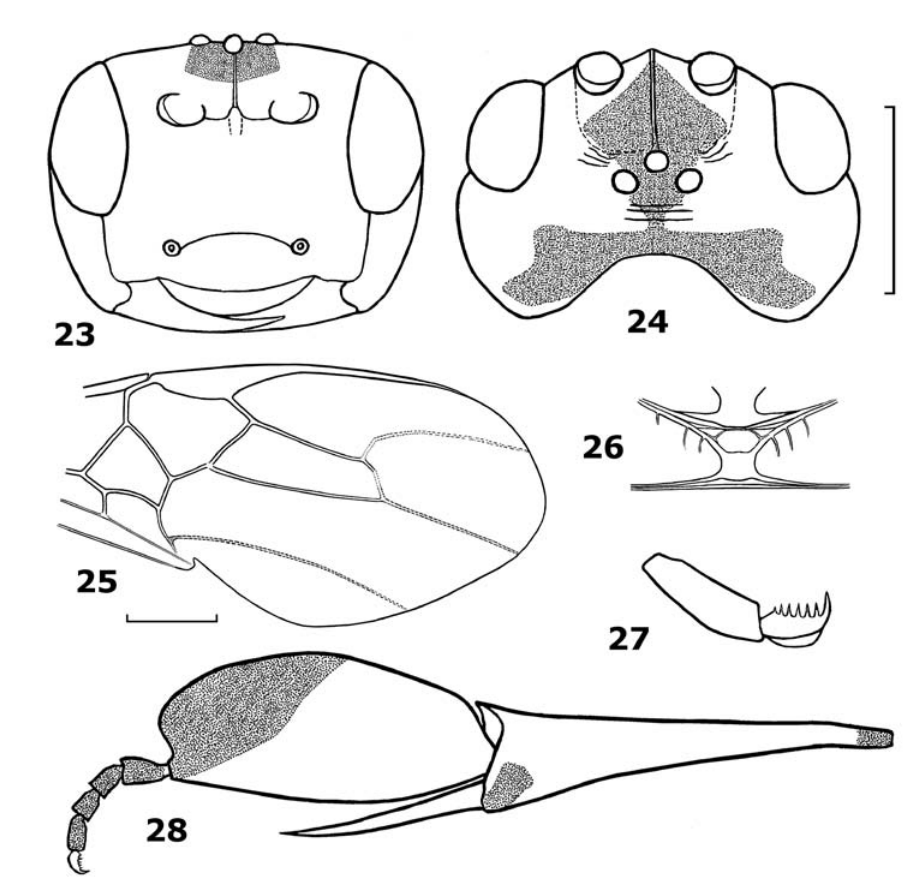
25 fore wing 26 metanotum dorsal 27 hind tarsal claw 28 hind tibia and